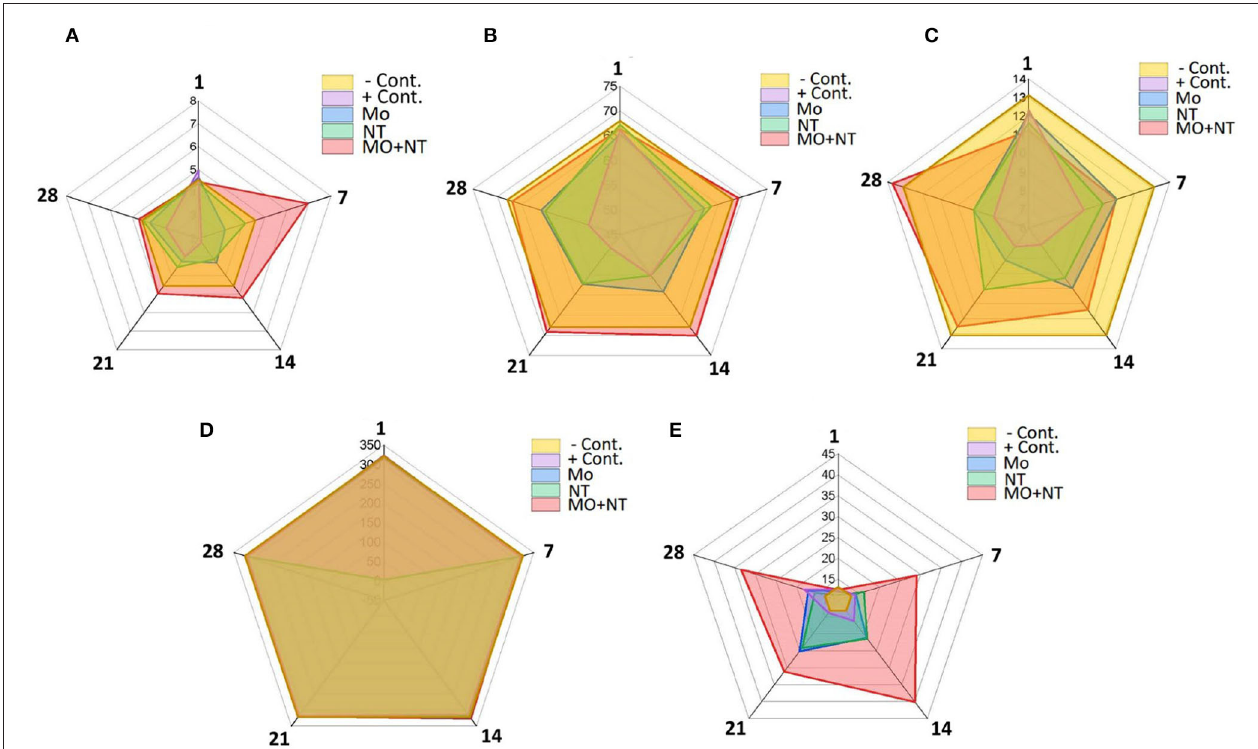
FIGURE 4 | Hematological changes at different days (1, 7, 14, 21, and 28). (A) Ref blood cell (RBC) (10 12 /l), (B) MCV (Fl), (C) MCH (pg), (D) PLT (10 9 /l), and (E) white blood cell (WBC) (10 9 /l).